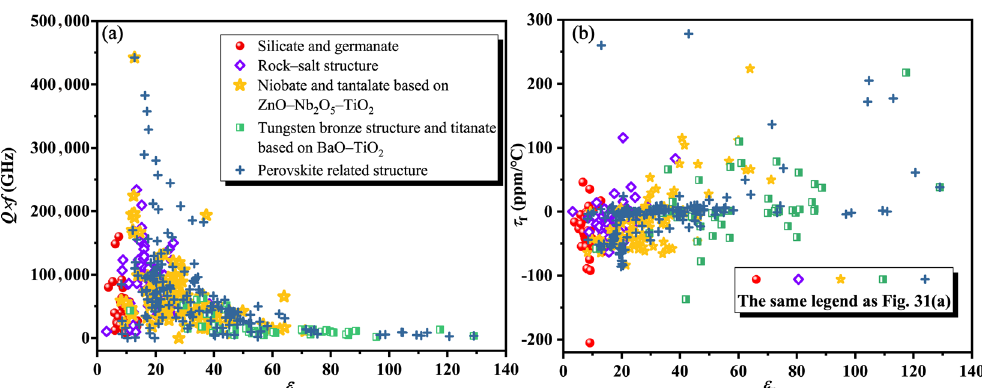
Fig. 31 Microwave dielectric properties of listed references: (a) ε r versus Q × f values and (b) ε r versus τ f